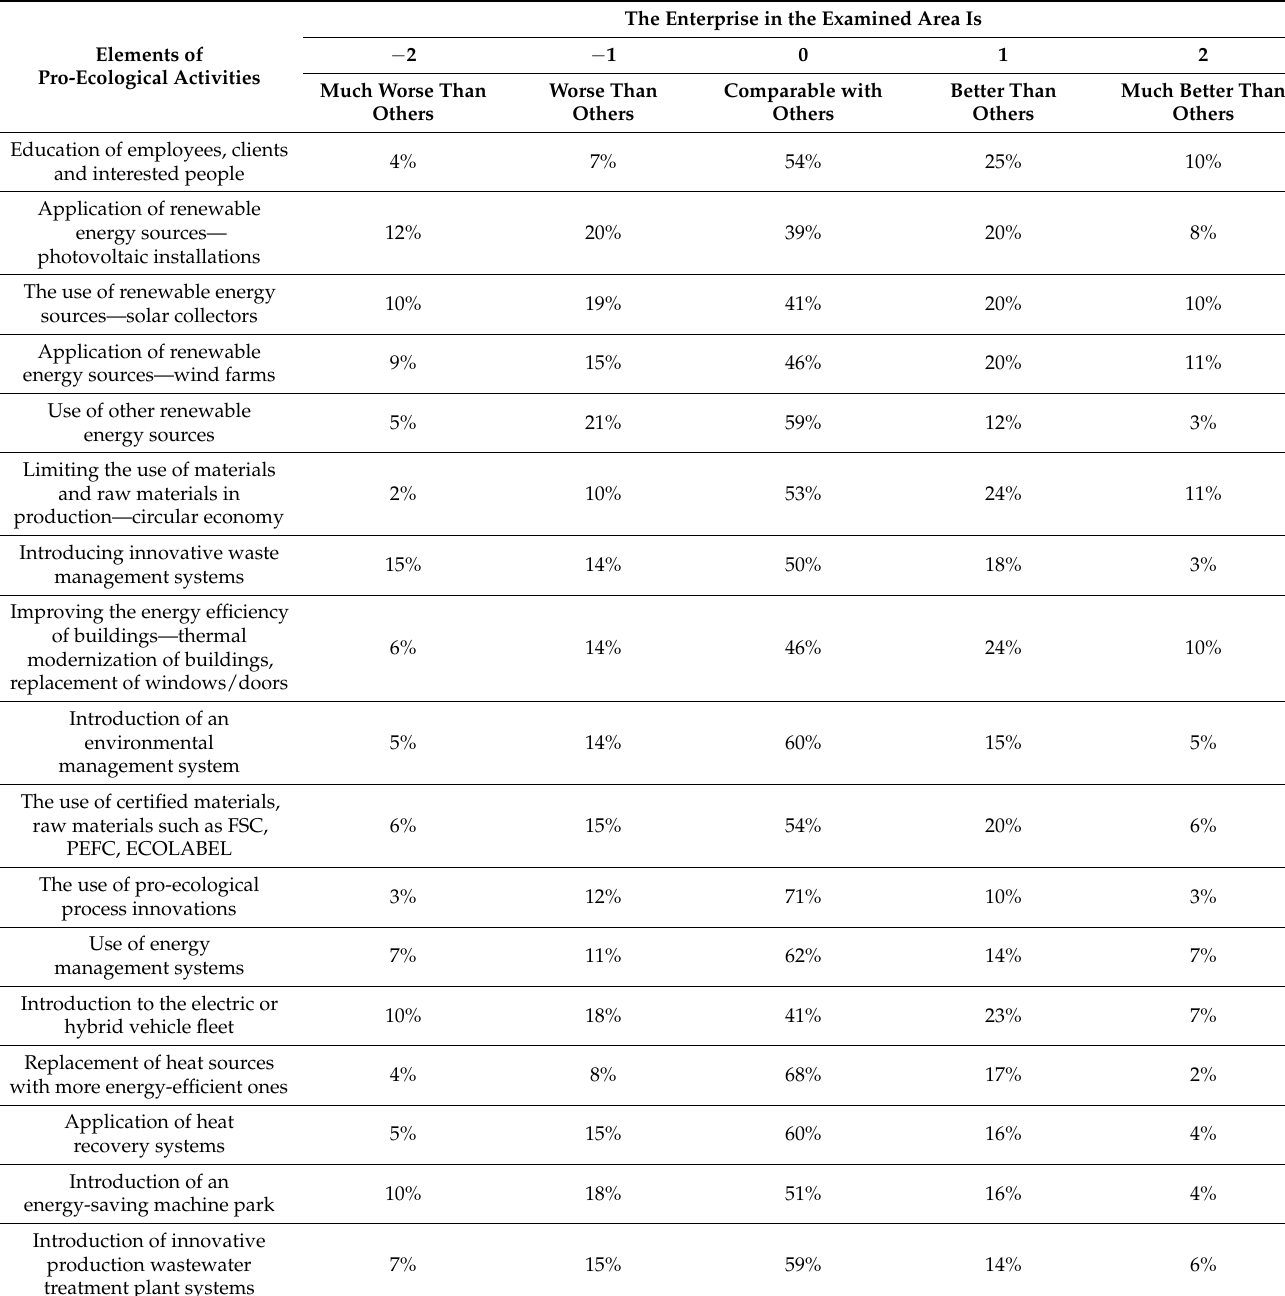
Table 6. Assessment of the competitive advantage of enterprises as regards pro-ecological